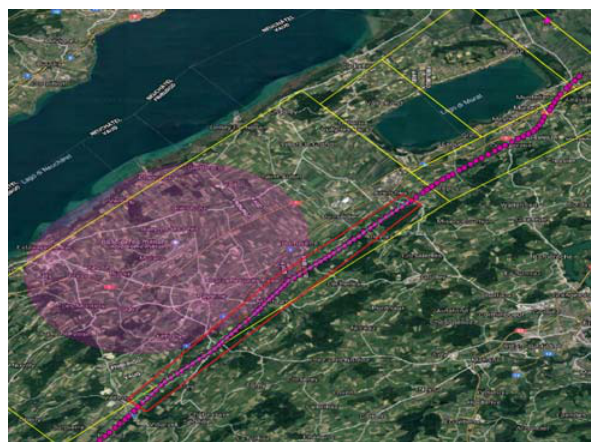
Figure 4. Demo flight